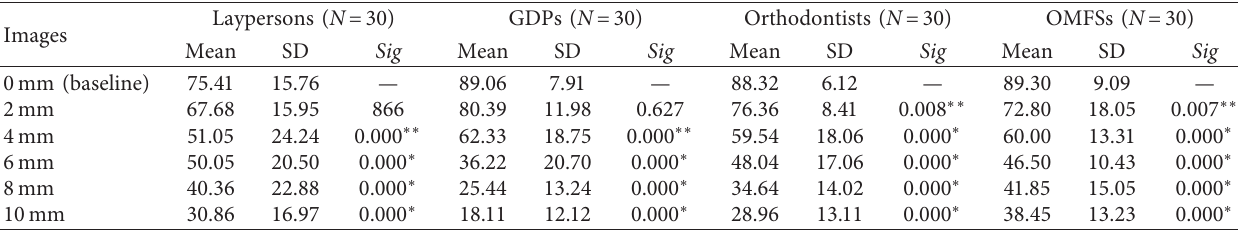
Table 2: Means and SDs of the esthetic values for the baseline face symmetry image and the manipulated images as perceived by the four raters groups. Images